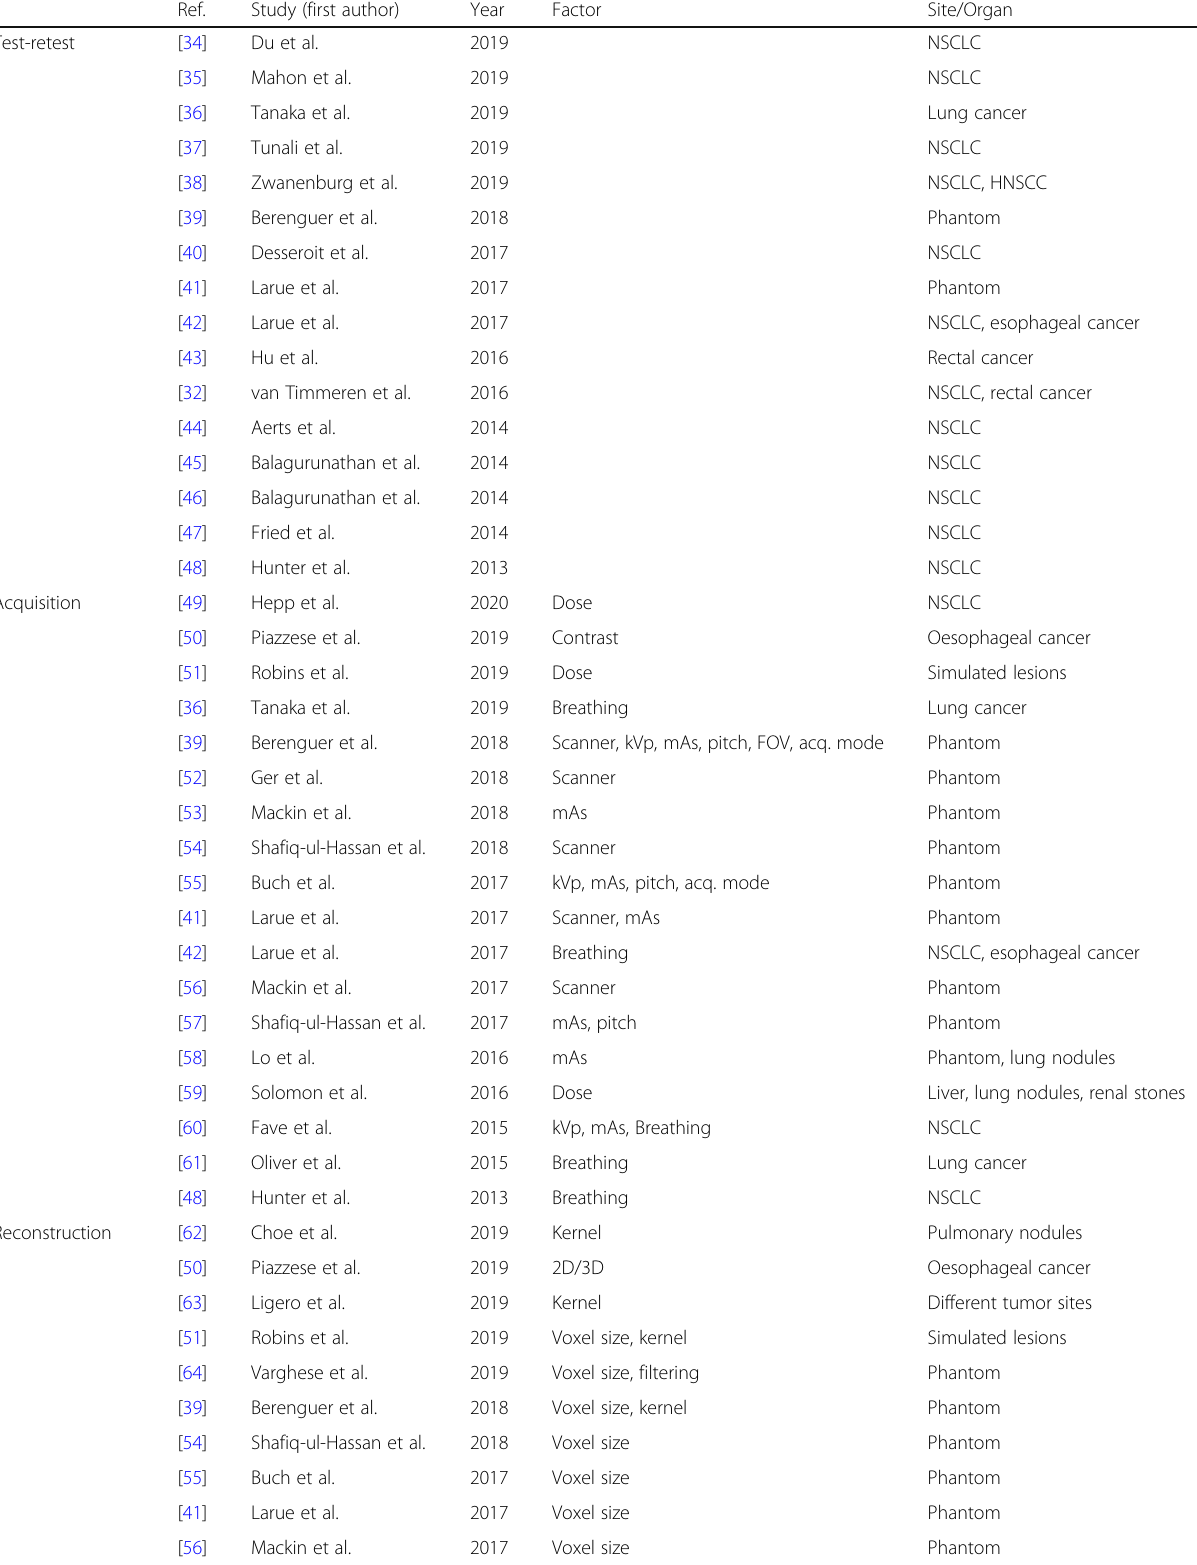
Table 1 Literature review for oncologic imaging or phantom studies with computed tomography